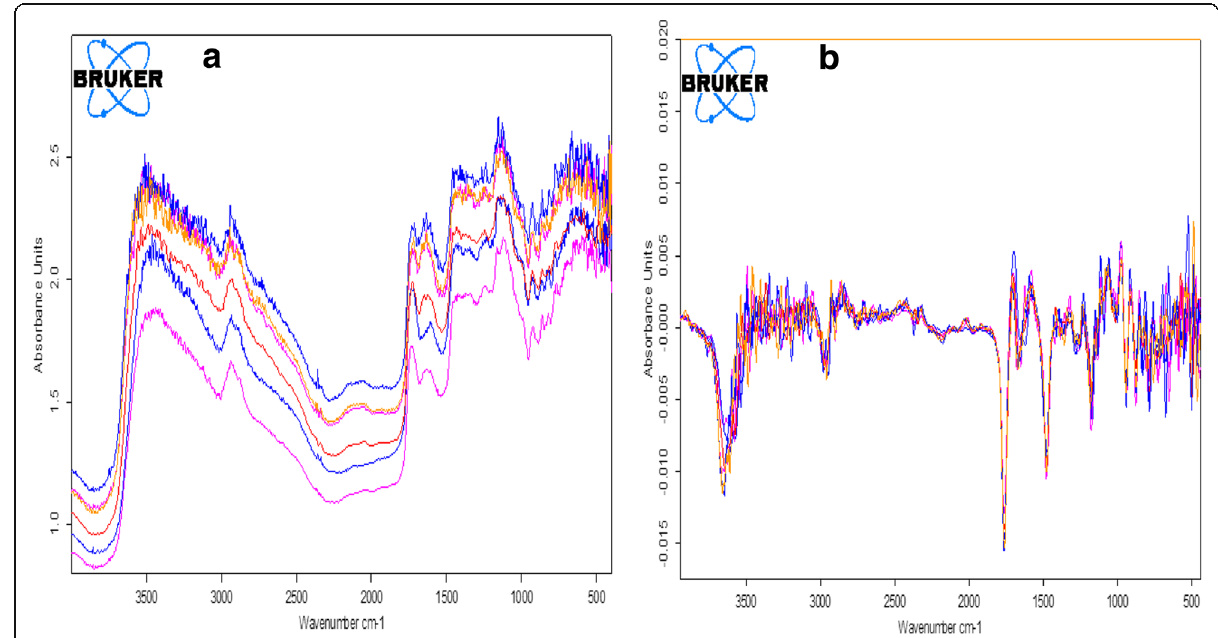
Fig. 2 Plot of factor loading values for the principal components used to fructose and glucose from MIR spectra